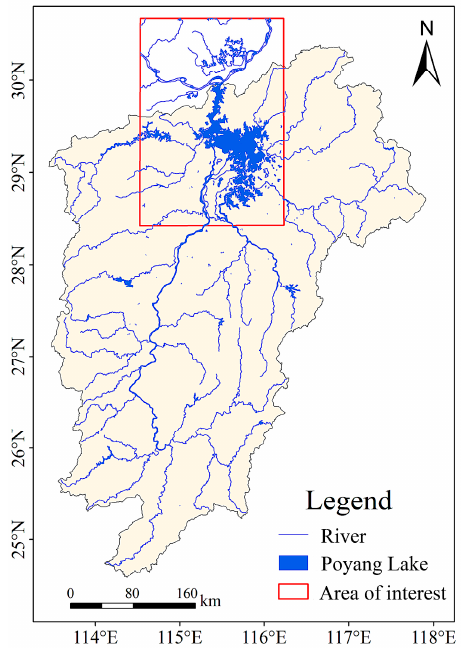
Figure 1. The river networks in Poyang Lake basin.